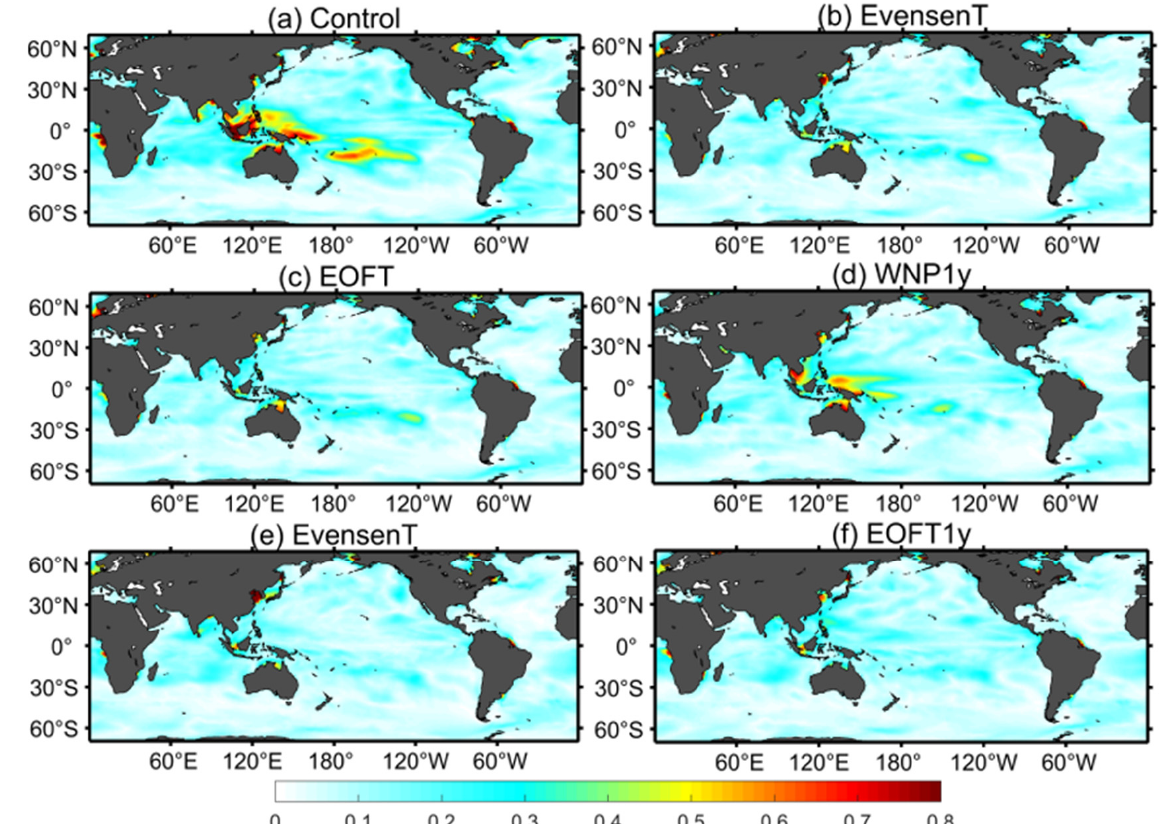
Figure 5. The SSS RMSE for ( a ) the control, ( b ) the EvensenT experiment, ( c ) the EOFT experiment, ( d ) the WNP1y experiment, ( e ) the EvensenT1y experiment, ( f ) the EOFT1y experiment (unit: psu).